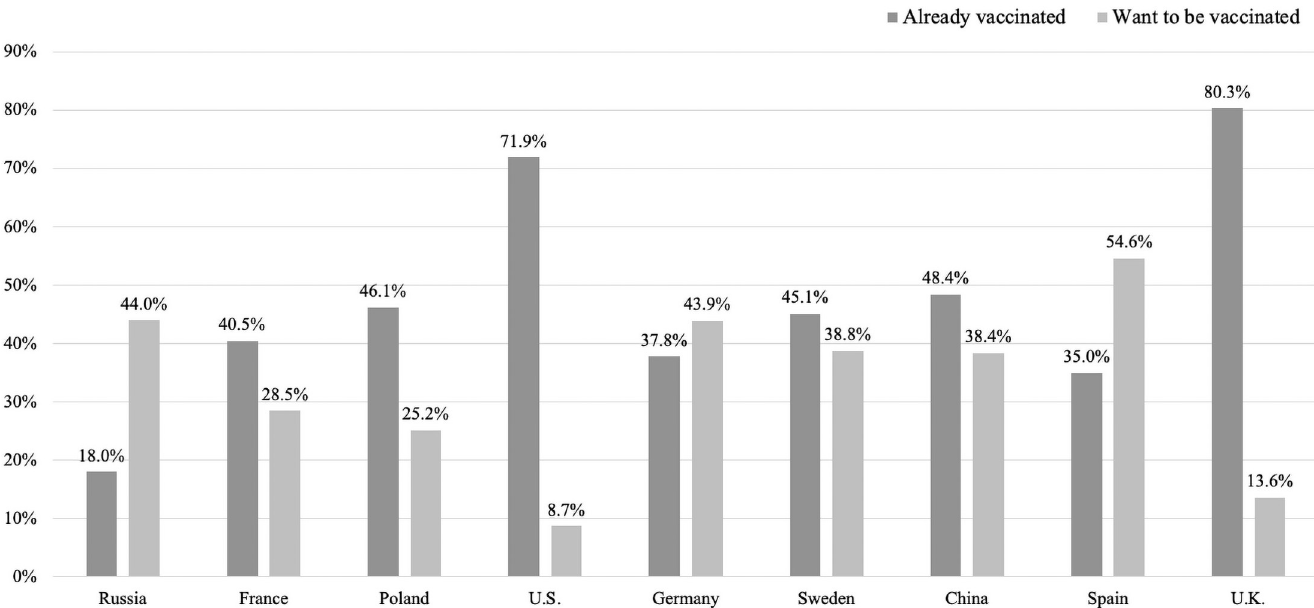
Fig 1. Percentage of participants who are already Covid-19 vaccinated or who want to be vaccinated (country-specific samples). Notes. China: N = 1,020, France: N = 1,001, Germany: N = 1,145, Poland: N = 1,004, Russia: N = 1,024, Spain: N = 985, Sweden: N = 1,003, the U.K.: N = 1,050, the U.S.: N = 1,032.